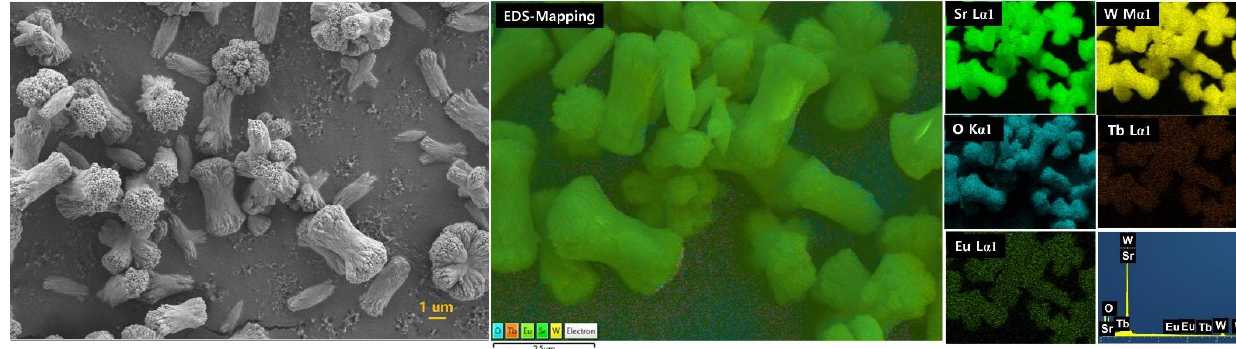
Figure 6. FE-SEM images and EDS mapping analysis of SrWO 4 :[Eu 3+ ]/[Tb 3+ ]. Figure 7(a) shows the emission spectrum of the SrWO 4 :[Eu 3+ ]/[Tb 3+ ] phosphor pow- der co-doped with changing Eu 3+ ion concentrations, while the Tb 3+ ion concentration re- mained fixed. The emission spectra of the two rare earth ions were shown when excited at a wavelength of 254 nm, as the doping concentration of Eu 3+ increased. Green at 544 nm and orange – red at 614 nm were simultaneously observed. As the concentration of Eu 3+ ions increased, the intensity of the green emission by Tb 3+ ions decreased, which means that the emission energy was converted from Tb 3+ ions in the host lattice to Eu 3+ ions (Fig- ure 7(b)). The energy transfer efficiency from Tb 3+ to Eu 3+ ions can be expressed by Equa- tion (1) [31].